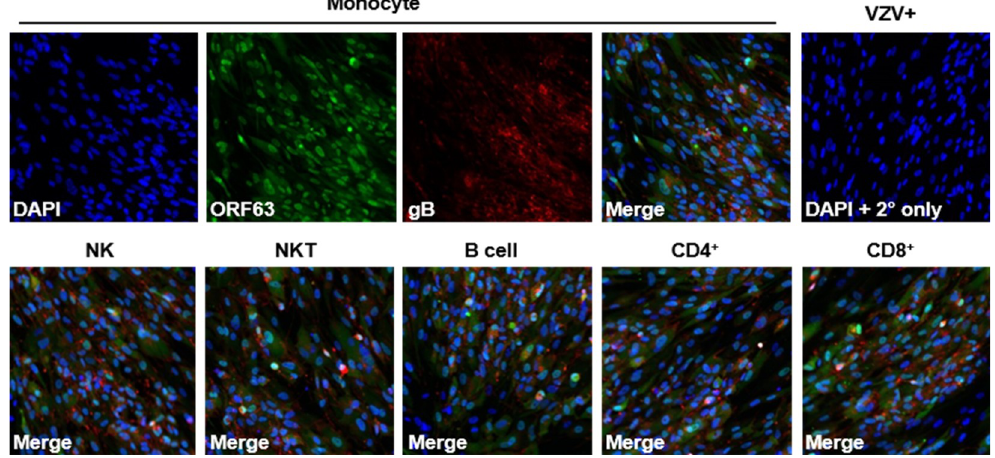
Fig 4. Monocytes, NK cells, NKT cells, B cells, CD4 + T cells and CD8 + T cells are productively infected by VZV and capable of transmitting virus. Human PBMCs were co-cultured with VZV-infected HFLs for 48 h, then VZV-infected monocytes, NK, NKT, B cells, CD4 + T and CD8 + T cells were sorted using flow cytometry. Individual sorted immune cells were then washed with citrate buffer followed by FACS buffer before co-culturing with uninfected HFLs. After 5 days of co- culture, immunofluorescence analyses of VZV ORF63 (green) and VZV glycoprotein B (gB, red) revealed productive infection of HFLs by all individual immune cell populations analyzed. Specifically, top panels 1 to 3 (left to right) show individual channels for DAPI, ORF 63 and VZV gB in HFLs exposed to VZV-infected monocytes—with panel 4 representing a merged image demonstrating expression of both VZV proteins. Lower merged panels show co-expression of ORF 63 and VZV gB in HFLs exposed to VZV-infected NK cells, NKT cells, B cells, CD4 + T cells and CD8 + T cells. Negative controls were provided by omission of primary antibody on VZV-infected HFLs (top right panel). DAPI (blue) was used as cell nucleus stain. Magnification, X100. Results representative of duplicate experiments using PBMCs from 2 different healthy